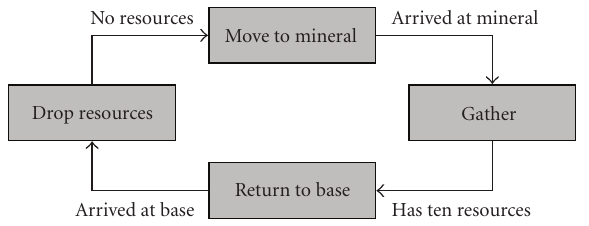
Figure 1: The finite state machine used by the workers in a resource gathering scenario.